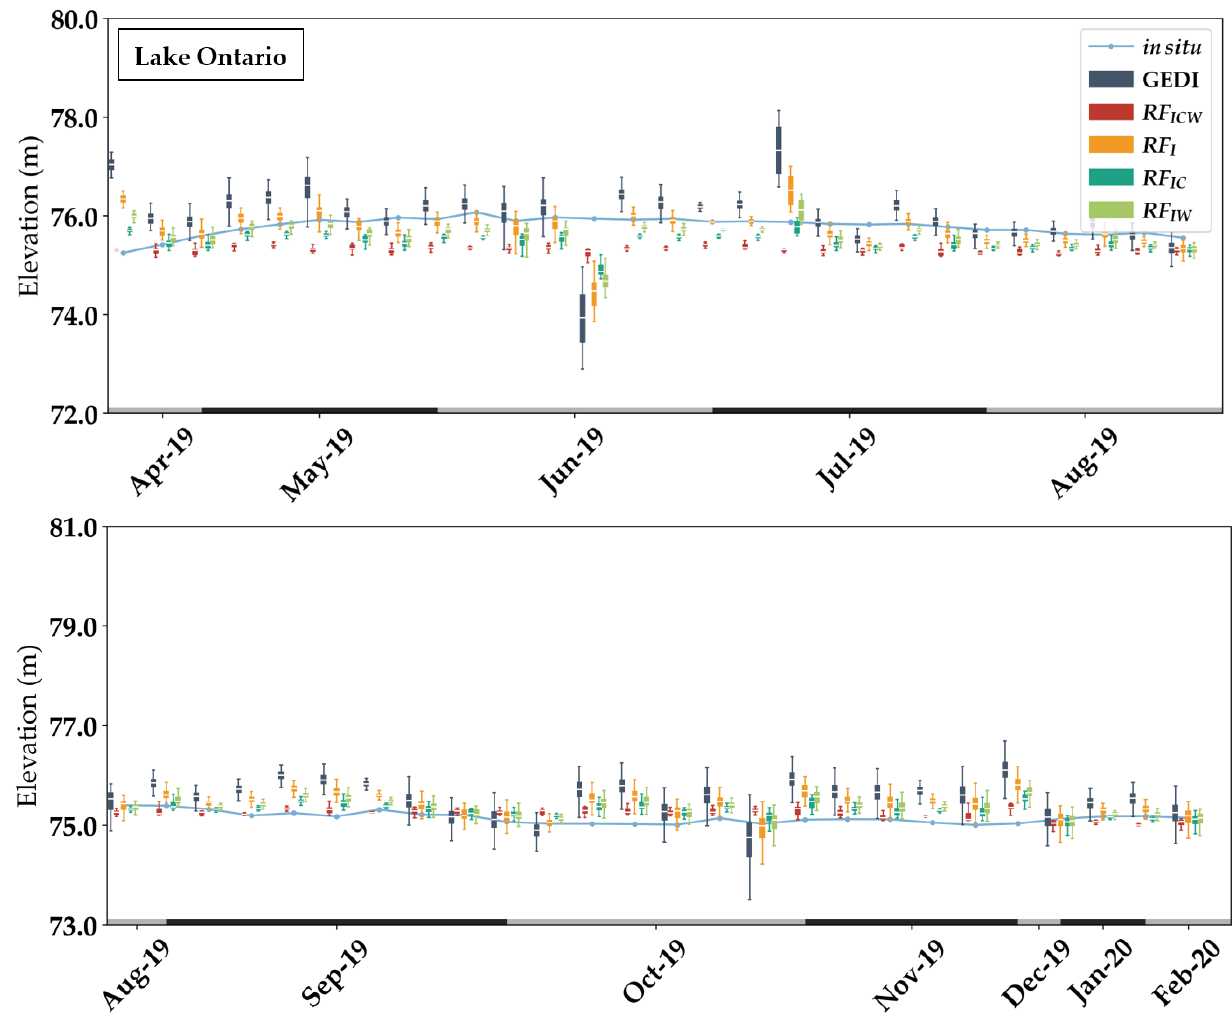
Figure A2. Box plot by track of the original estimated elevations by GEDI over Lake Erie and the four tested models presented in Sections 3.1.1 and 3.1.2. The blue line represents in situ elevations.